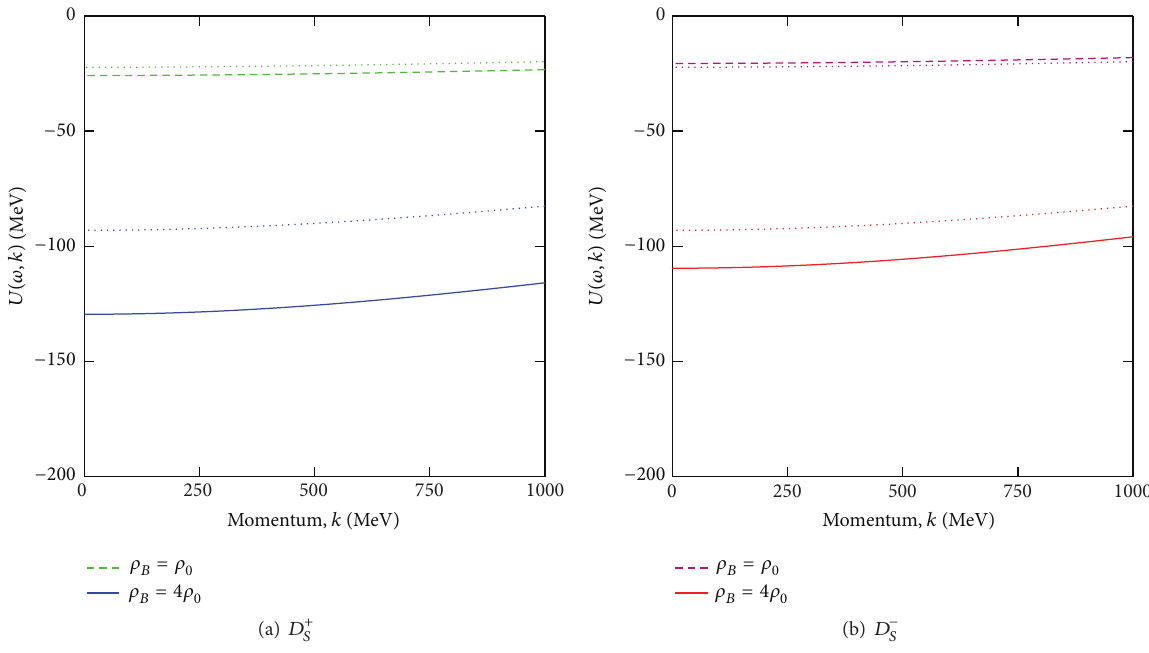
⃗𝑘| ), in cold (𝑇 = 0) , asymmetric ( 𝜂 = 0.5 )